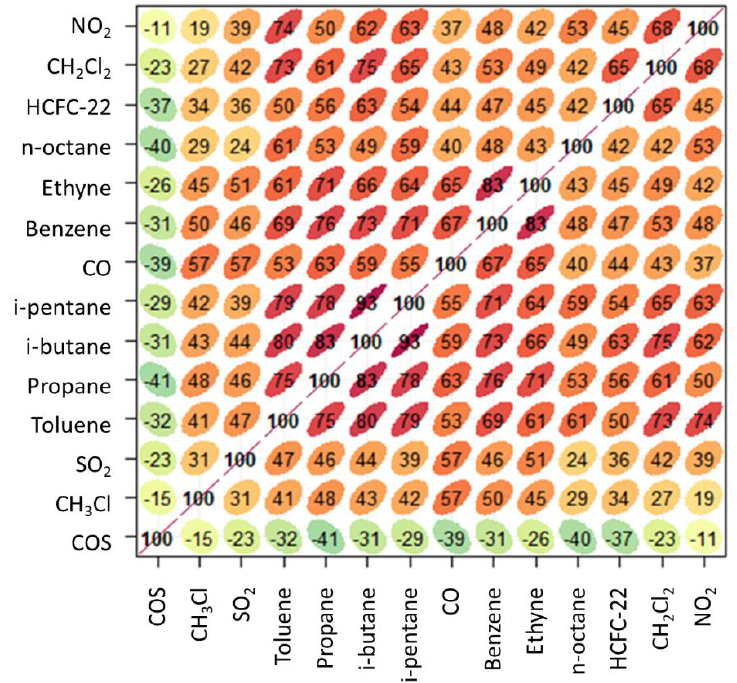
Figure 9. Multiple correlation analysis of the nighttime dataset for summer 2017. The shape of ellipses provides a visual representation of the scatter plot for each couple of variables, the numbers and the colour code give representation of the R value (green: negative slope of correlation, red: positive slope of correlation).